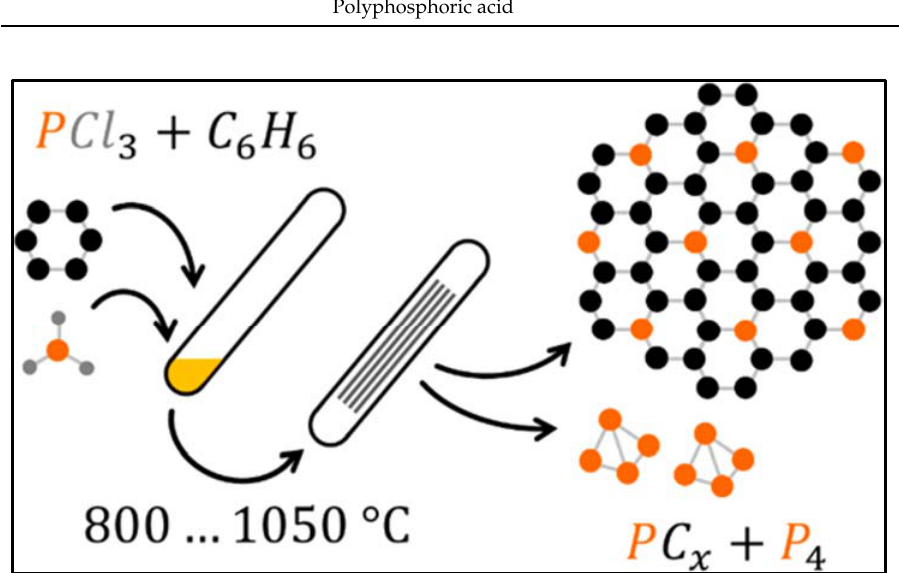
Figure 3. Synthesis of P-GNS using phosphorous trichloride (PCl 3 ) and benzene (C 6 H 6 ) as precursors. Adapted from Billeter et al. [74], with permission from the American Chemical Society. Copyright (2018).